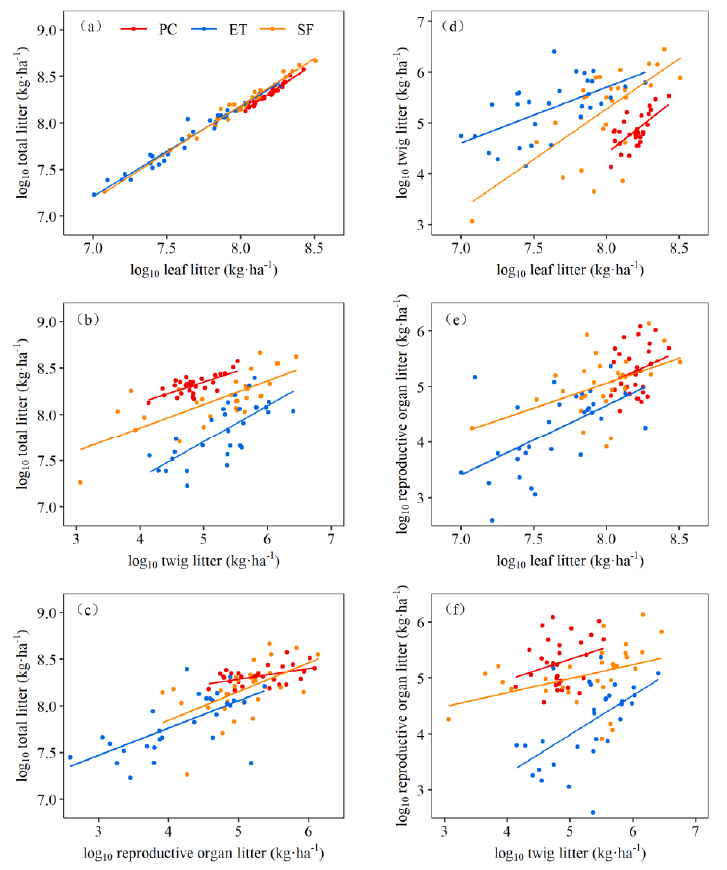
Figure 5. Allometric relationships between each litter component and total litterfall ( a – c ) and among litter components ( d – f ) in different plantations. PC: pure cypress; SF: strip filling; ET: ecological thinning.